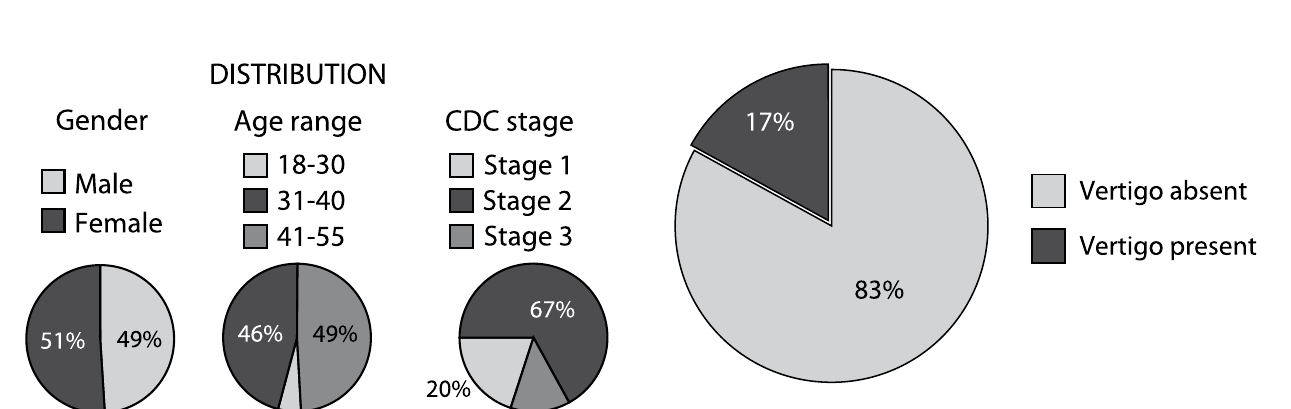
Figure 2: The occurrence of vertigo in the sample evaluated ( N =